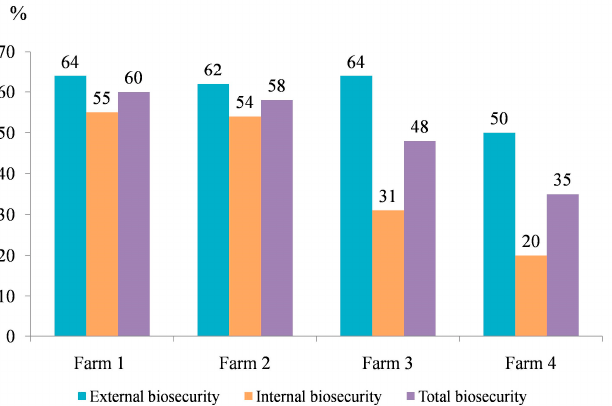
Figure 1. Biosecurity measures on four selected commercial fattening pigs’ farms.